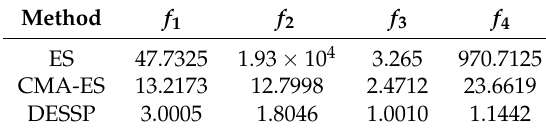
Table 13. The averages of the best function values obtained by ES, CMA-ES, and DESSP.